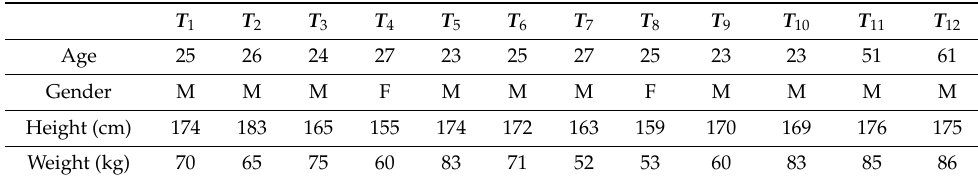
Table 9. Participants involved in testing.